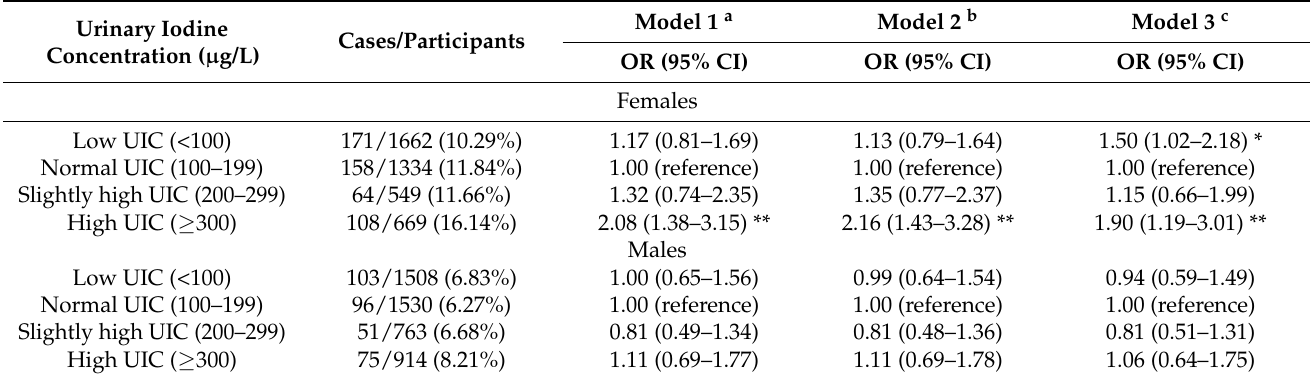
Table 3. Weighted ORs and 95% CIs of depressive symptoms stratified by